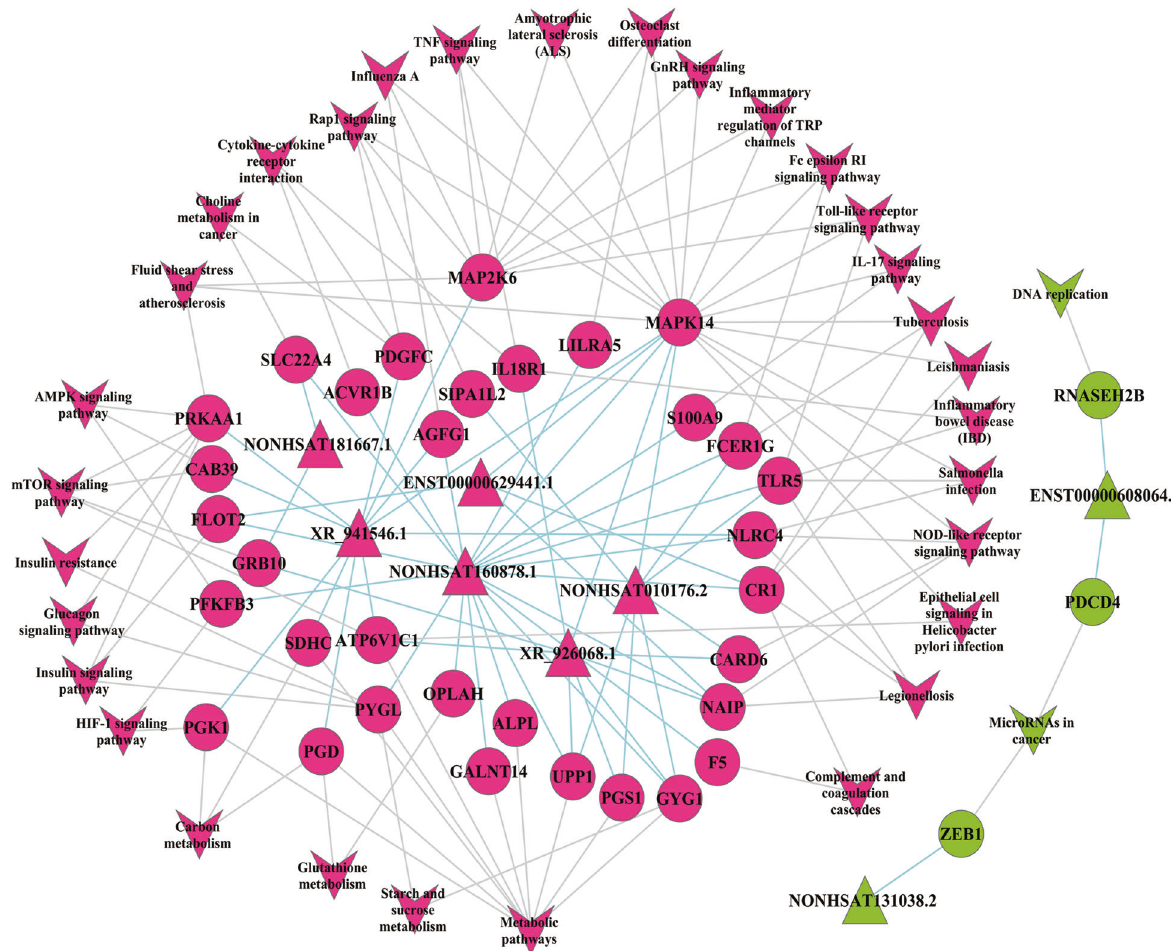
Fig. 2 Pathway network analysis of the signi fi cantly differentially expressed lncRNAs and mRNAs. The role of each pathway in the network was measured by counting its connections to upstream and downstream pathways. A pathway with a high degree value likely plays an important role in the signaling network. Circles indicate mRNAs and triangles indicate lncRNAs. Red represents upregulated pathways and green represents downregulated pathways. Baby blue lines indicate the interaction between lncRNAs and mRNAs, and gray lines indicate interactions between